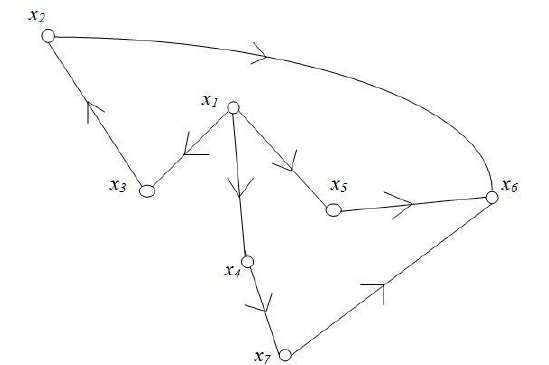
Figure 1. Existence of a path with a start point.